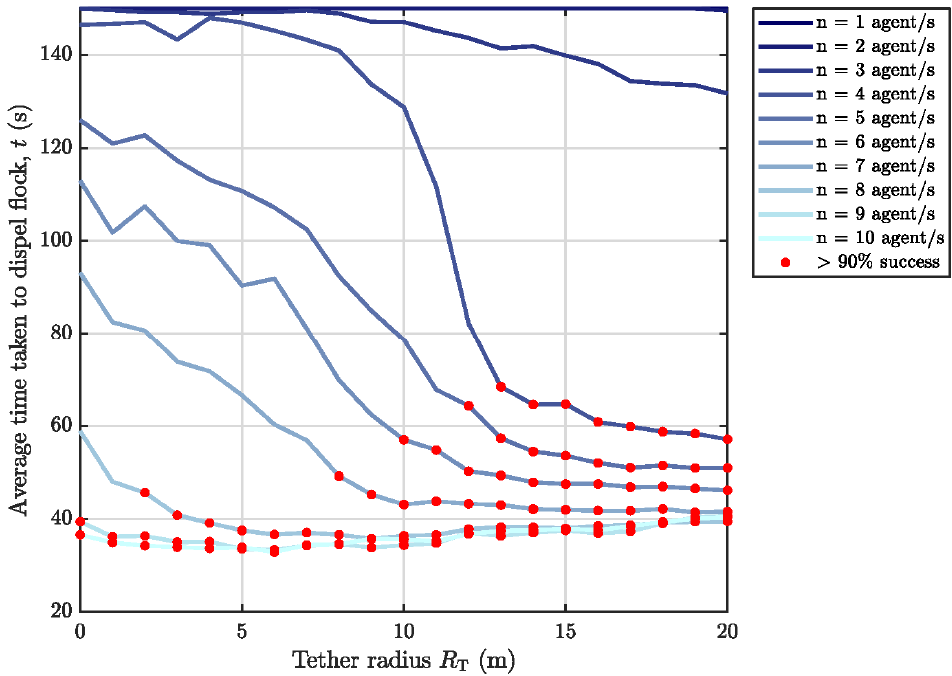
Figure 11. Double target flock scenarios–time performance (darker lines indicate fewer agent numbers while red markers indicate data points whose average success rate is above the given threshold across the 300 independent simulation runs). Maximum agent speed 𝑣 max = 12 m/s.